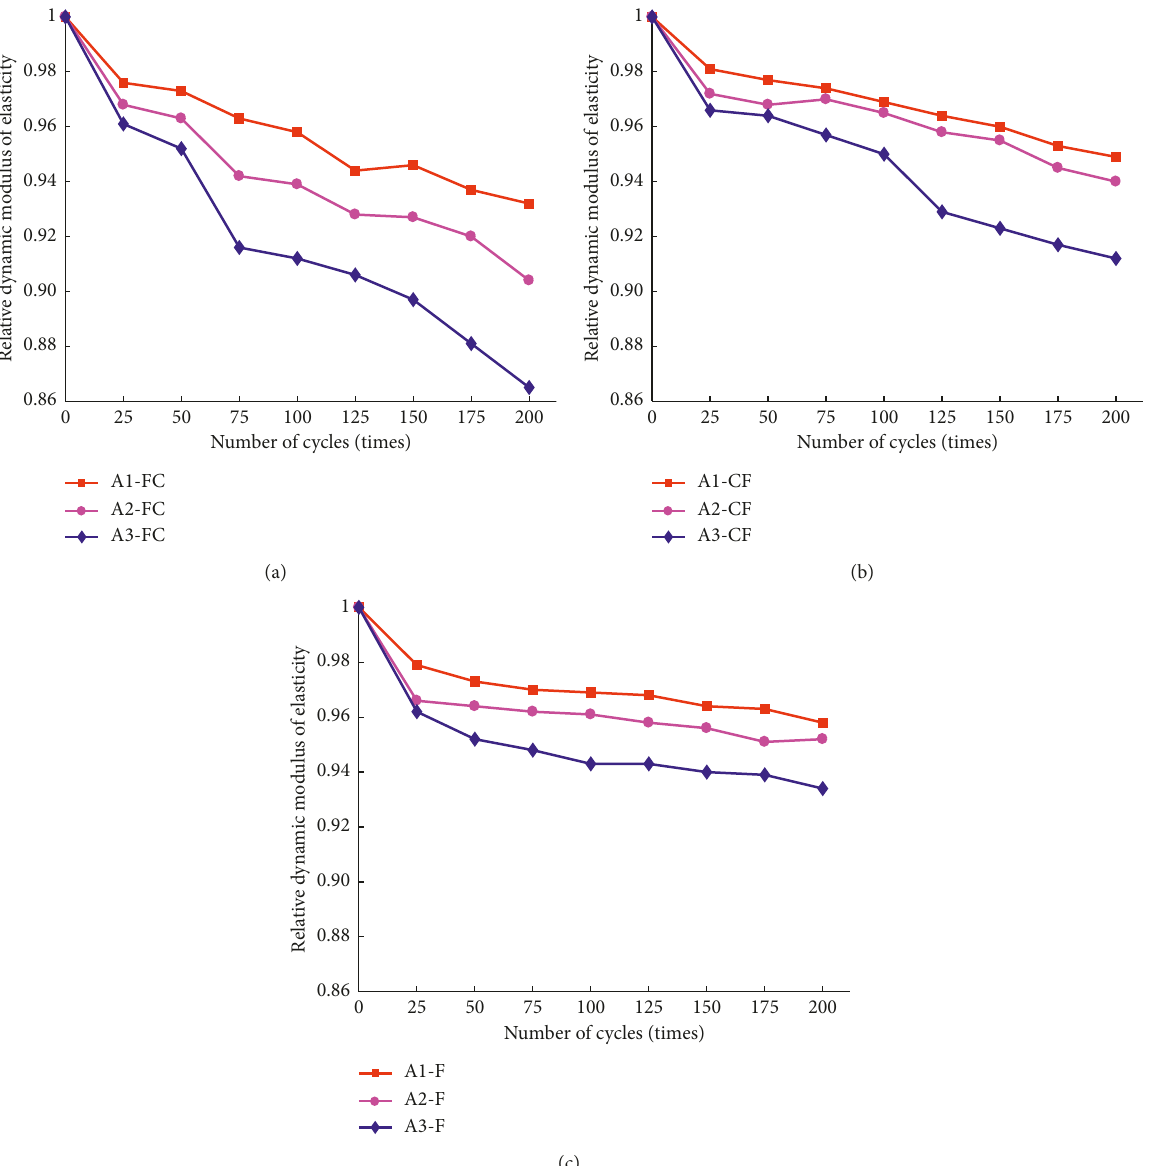
Figure 6: Relative dynamic modulus of elasticity of A1, A2, and A3 for different testing modes: (a) FC mode; (b) CF mode; (c) F